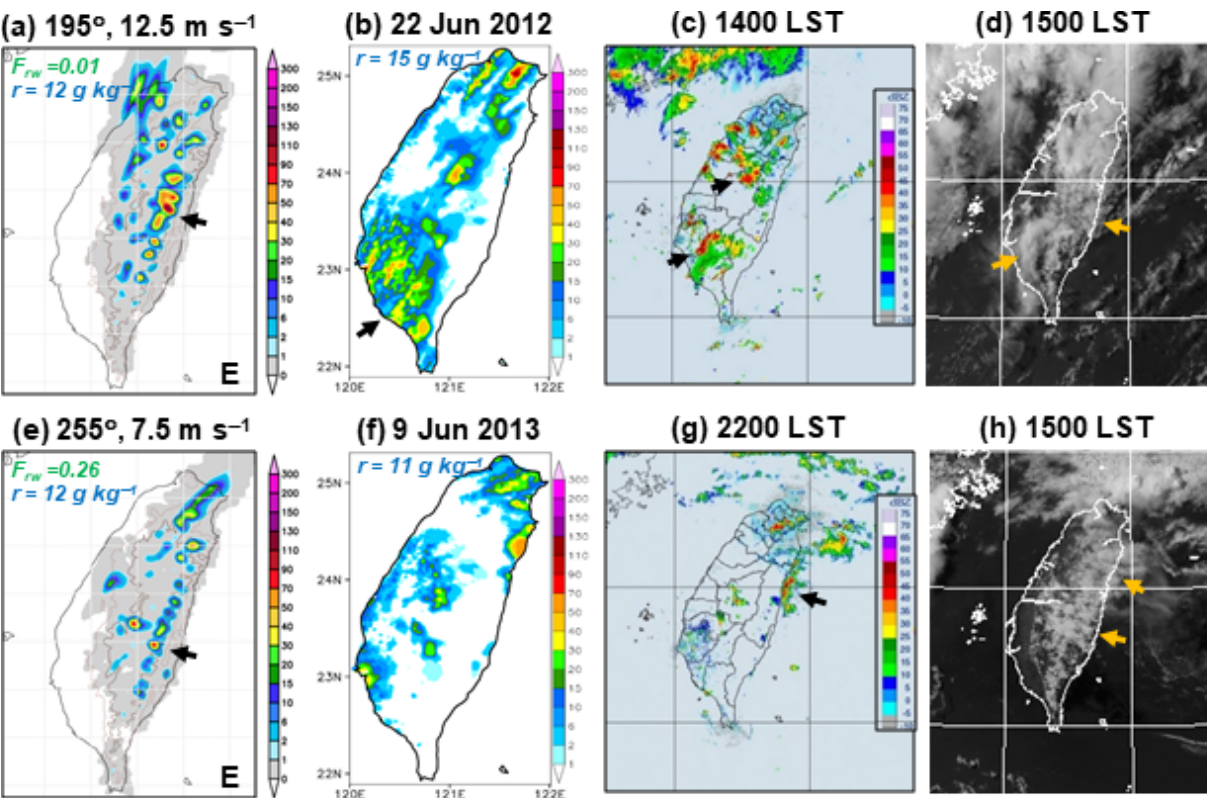
Figure 12. As in Fig. 11 but between idealized results and observations (source: CWB and NCDR) for different flow directions from parallel to more perpendicular in the low- Fr w regime. The two idealized cases are (a) 12.5ms − 1 from 195 ◦ and (e) 7.5ms − 1 from 255 ◦ , and the corresponding dates under observation are (b–d) 22 June 2012 and (f–h) 9 June 2013, respectively.